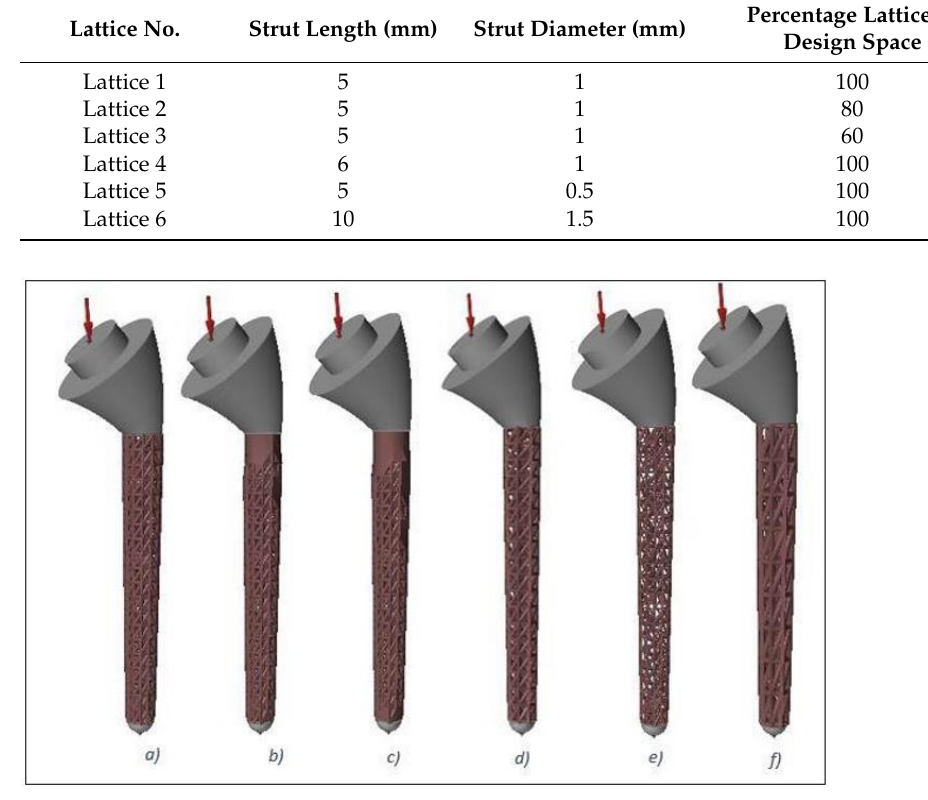
Figure 2. Humeral stems with lattice structures produced using lattice optimisation. From left to right: ( a ) Lattice 1; ( b ) Lattice 2; ( c ) Lattice 3; ( d ) Lattice 4; ( e ) Lattice 5; and ( f ) Lattice 6, correspond- ing to the parameters described in Table